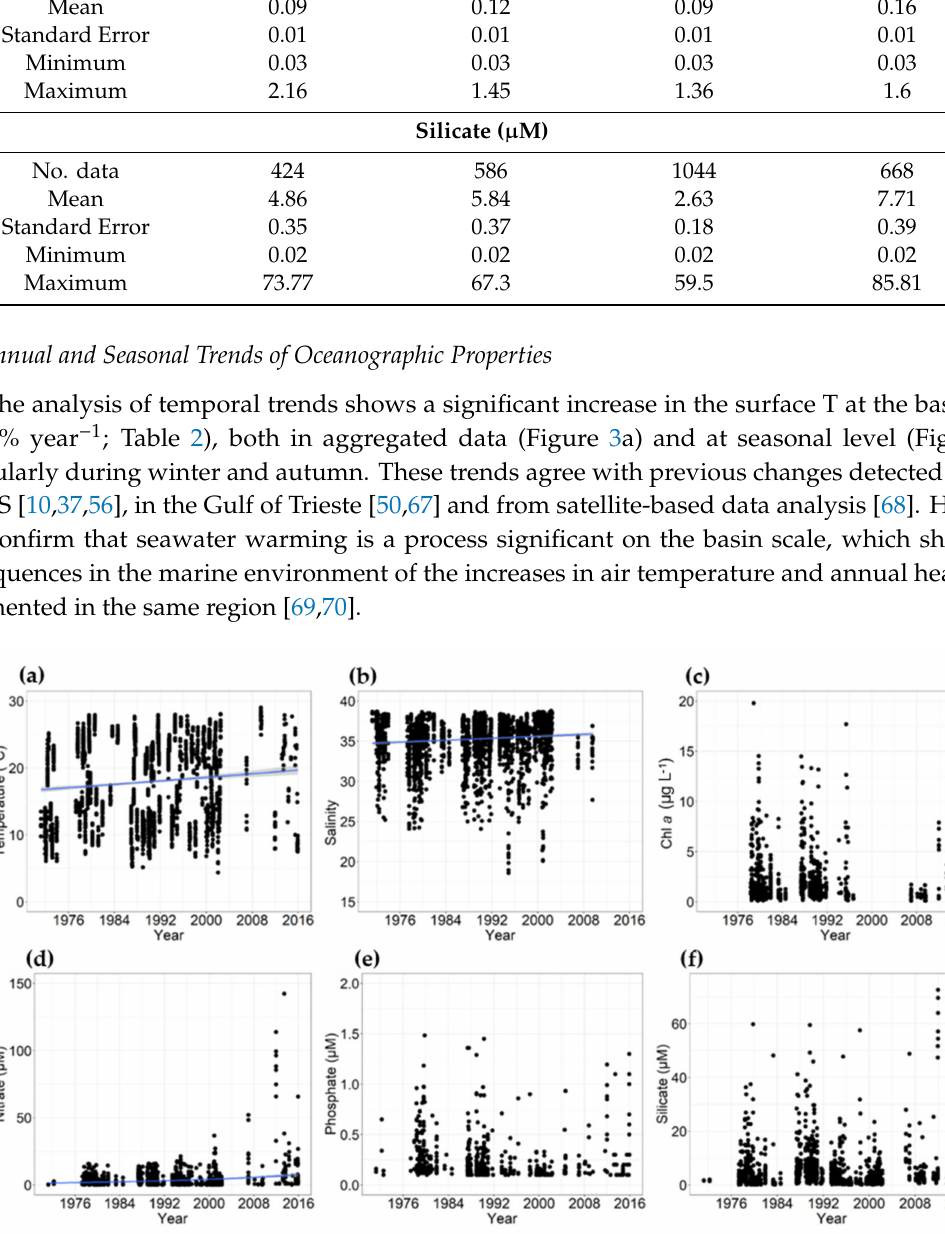
Figure 3. Trends of the aggregated data of ( a ) temperature ( ◦ C), ( b ) salinity, ( c ) chlorophyll- a ( µ g L − 1 ), ( d ) nitrate ( µ M), ( e ) phosphate ( µ M) and ( f ) silicate ( µ M) at the surface, in 1971–2015. The blue line represents the long-term trend with the 95% confidence limits (gray range). When the slope was not significant ( p -value > 0.05), the long-trend regression was not